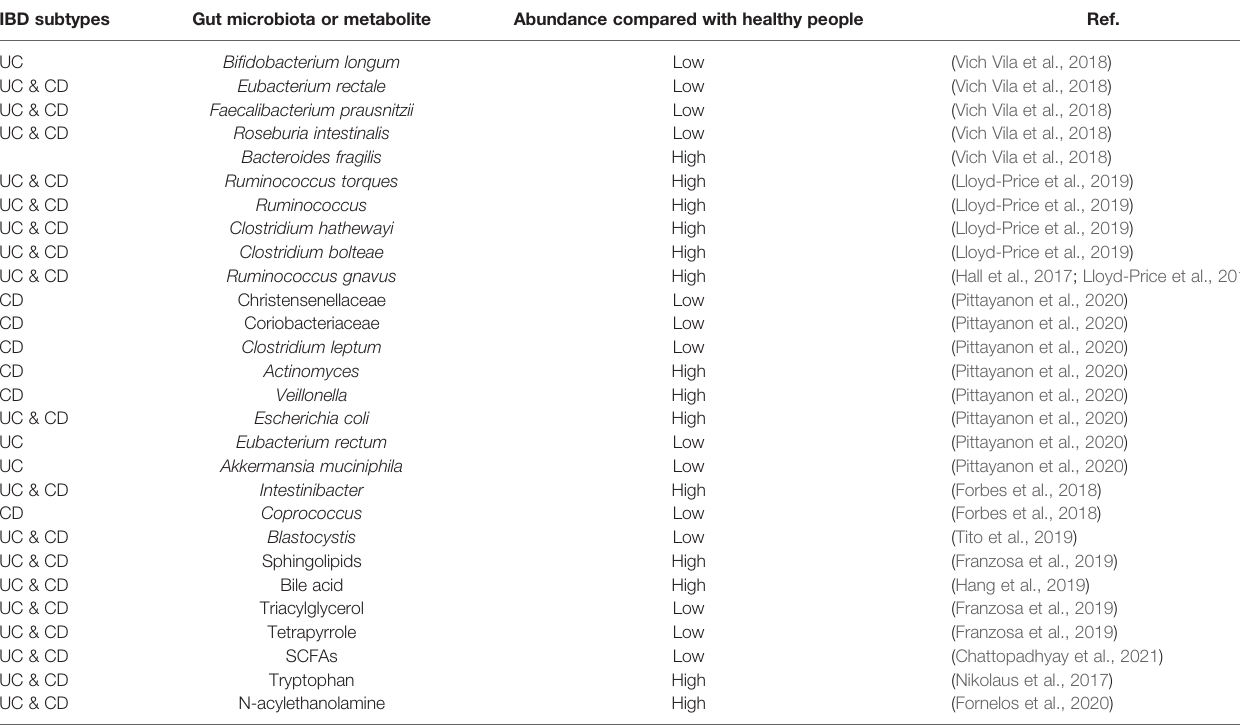
TABLE 1 | The classi fi cation and abundance of gut microbiota and microbiota-derived metabolites in